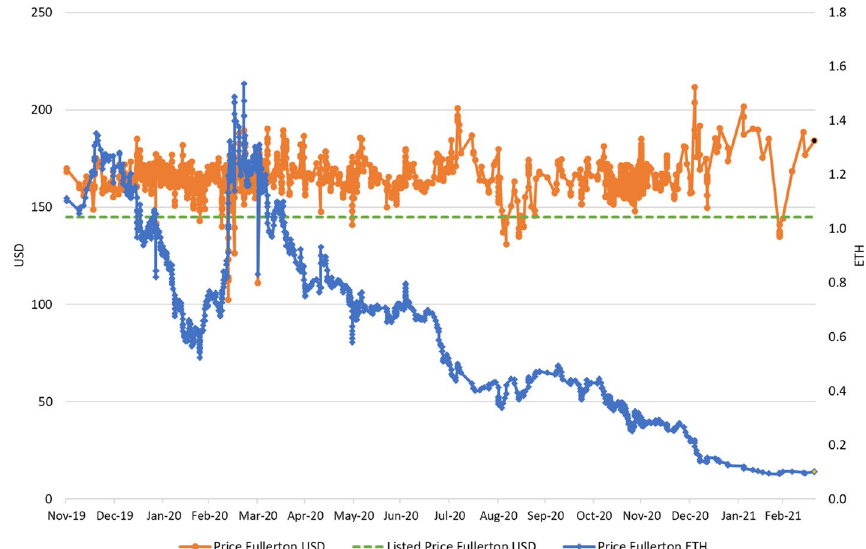
Fig. 11 Price (in USD and ETH) of 16,200 Fullerton Avenue Detroit MI. Each dot represents one transaction. Last colored dot is ask price on